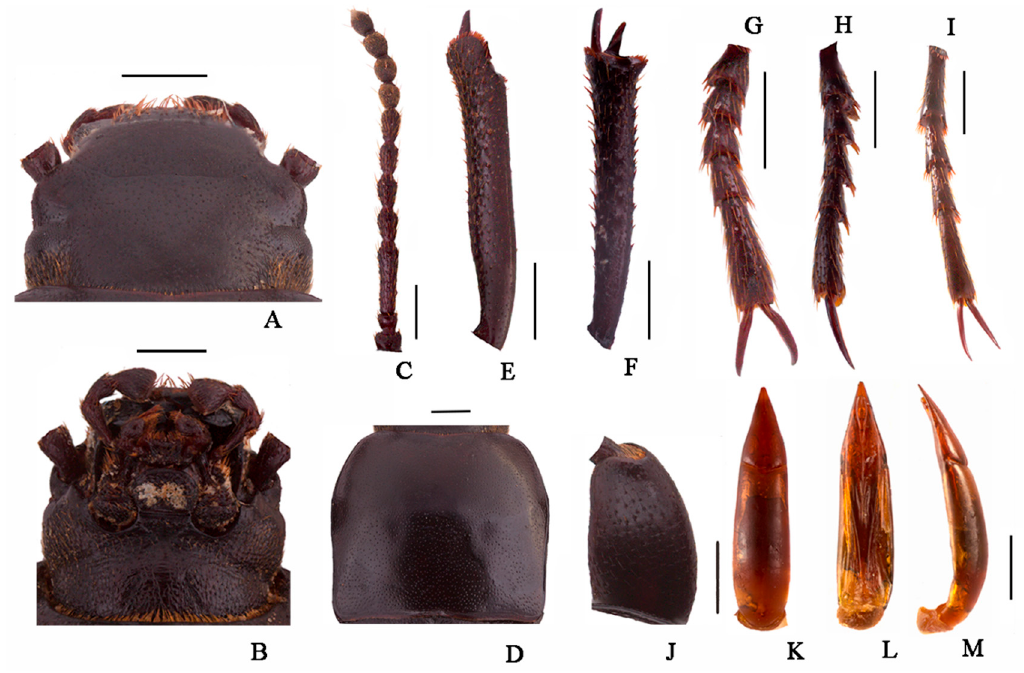
Figure 9. Nalepa xinlongensis sp. n. ( A ). head, dorsal view; ( B ). head, ventral view; ( C ). antenna; ( D ). pronotum; ( E ). protibia; ( F ). mesotibia; ( G ). protarsus; ( H ). mesotarsus; ( I ). metatarsus; ( J ). profem- ora; ( K – M ). aedeagus: ( K ). dorsal view; ( L ). ventral view; ( M ). lateral view. Scale bars: 1.0 mm.